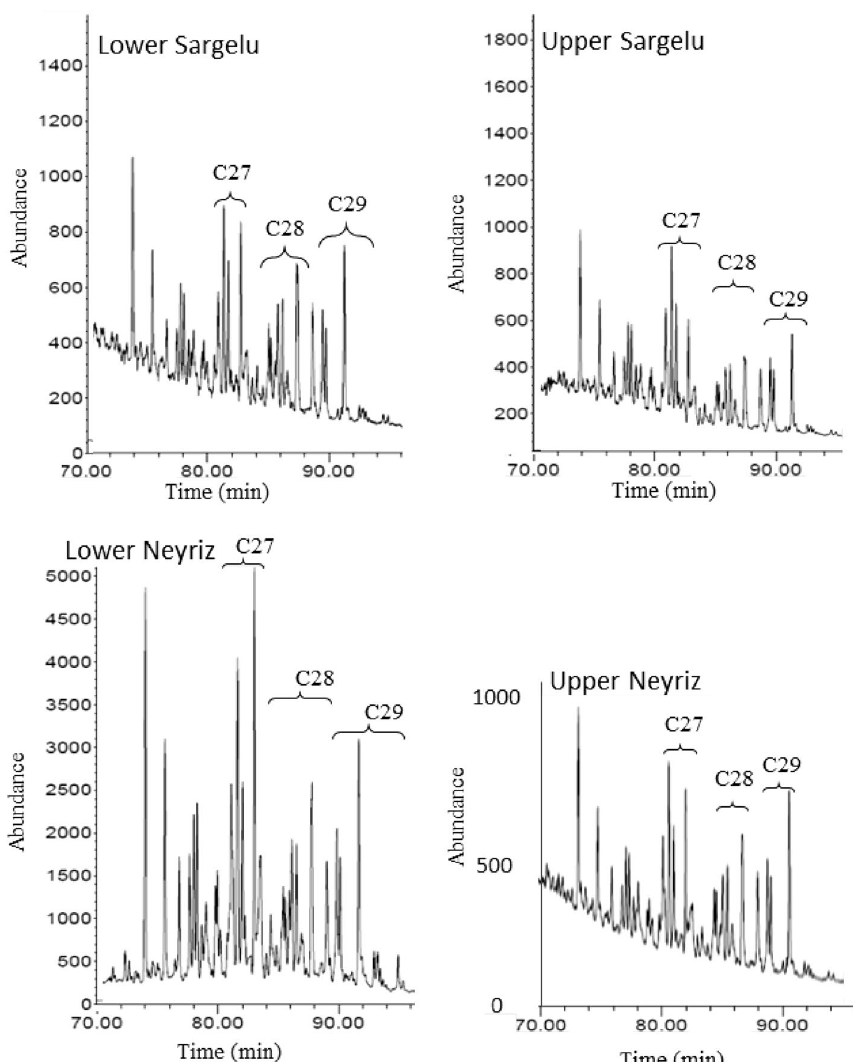
Fig. 10 Mass chromatograms ( m / z 217) of the studied cutting rock samples showing the distri- bution of